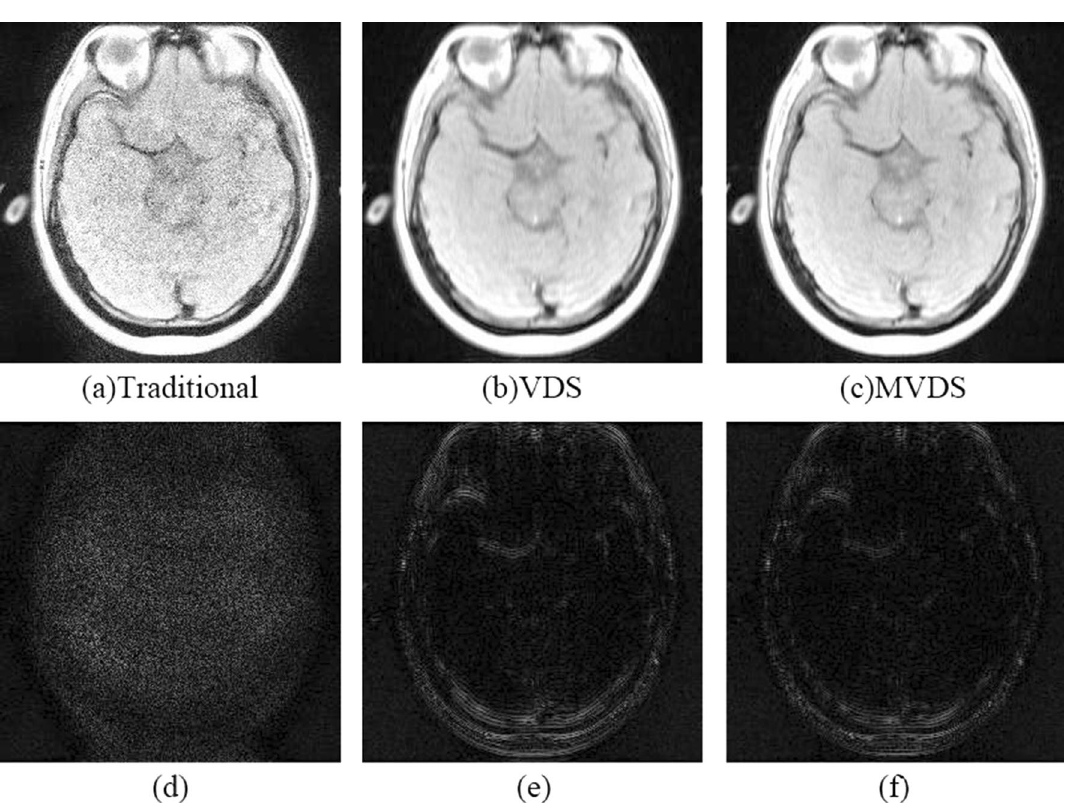
Figure 7. When R = 4 and ACS = 40, use GRAPPA to reconstruct the image to compare with traditional, VDS and MVDS methods. ( a ) The traditional method, and ( d ) the difference graph. ( b ) The VDS method, and ( e ) the corresponding difference map. ( c ) The MVDS method and ( f ) the difference graph.